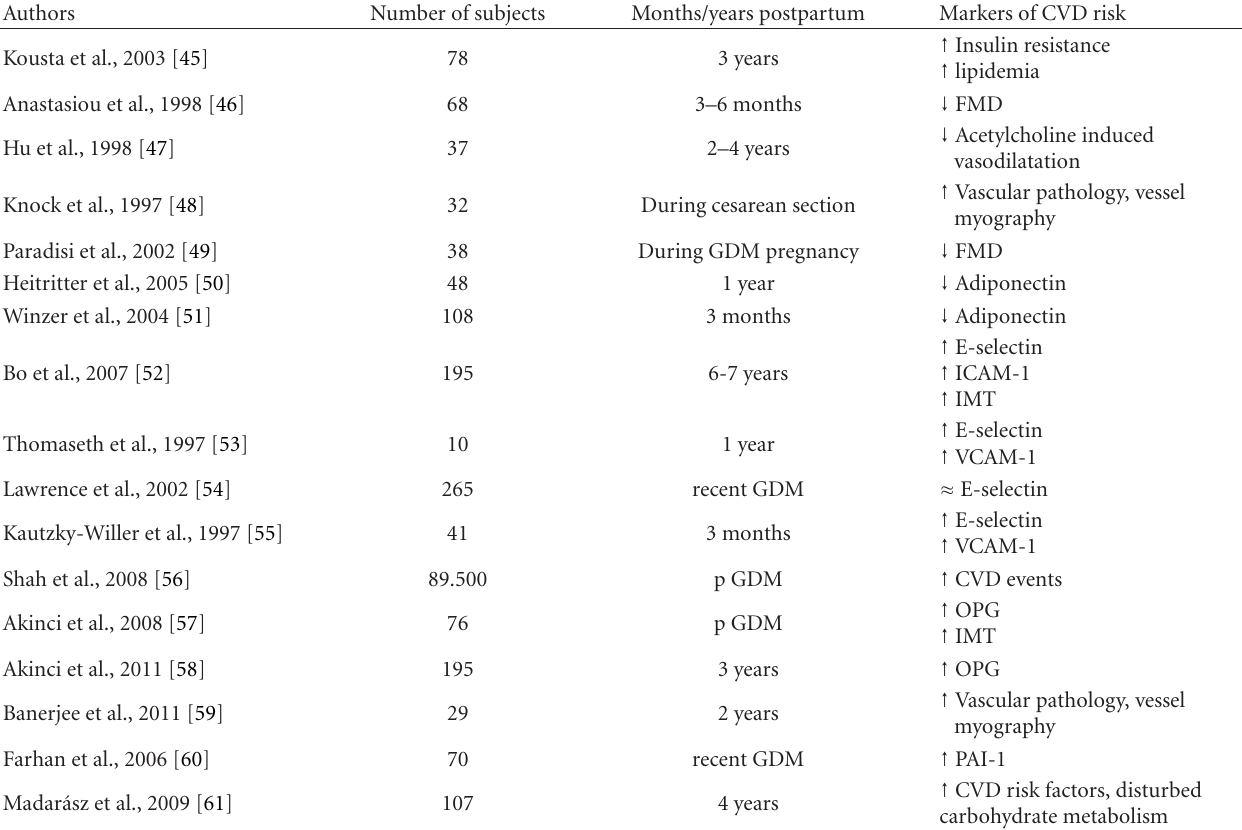
Table 1: Markers of increased CVD risk in normoglycemic women with GDM or